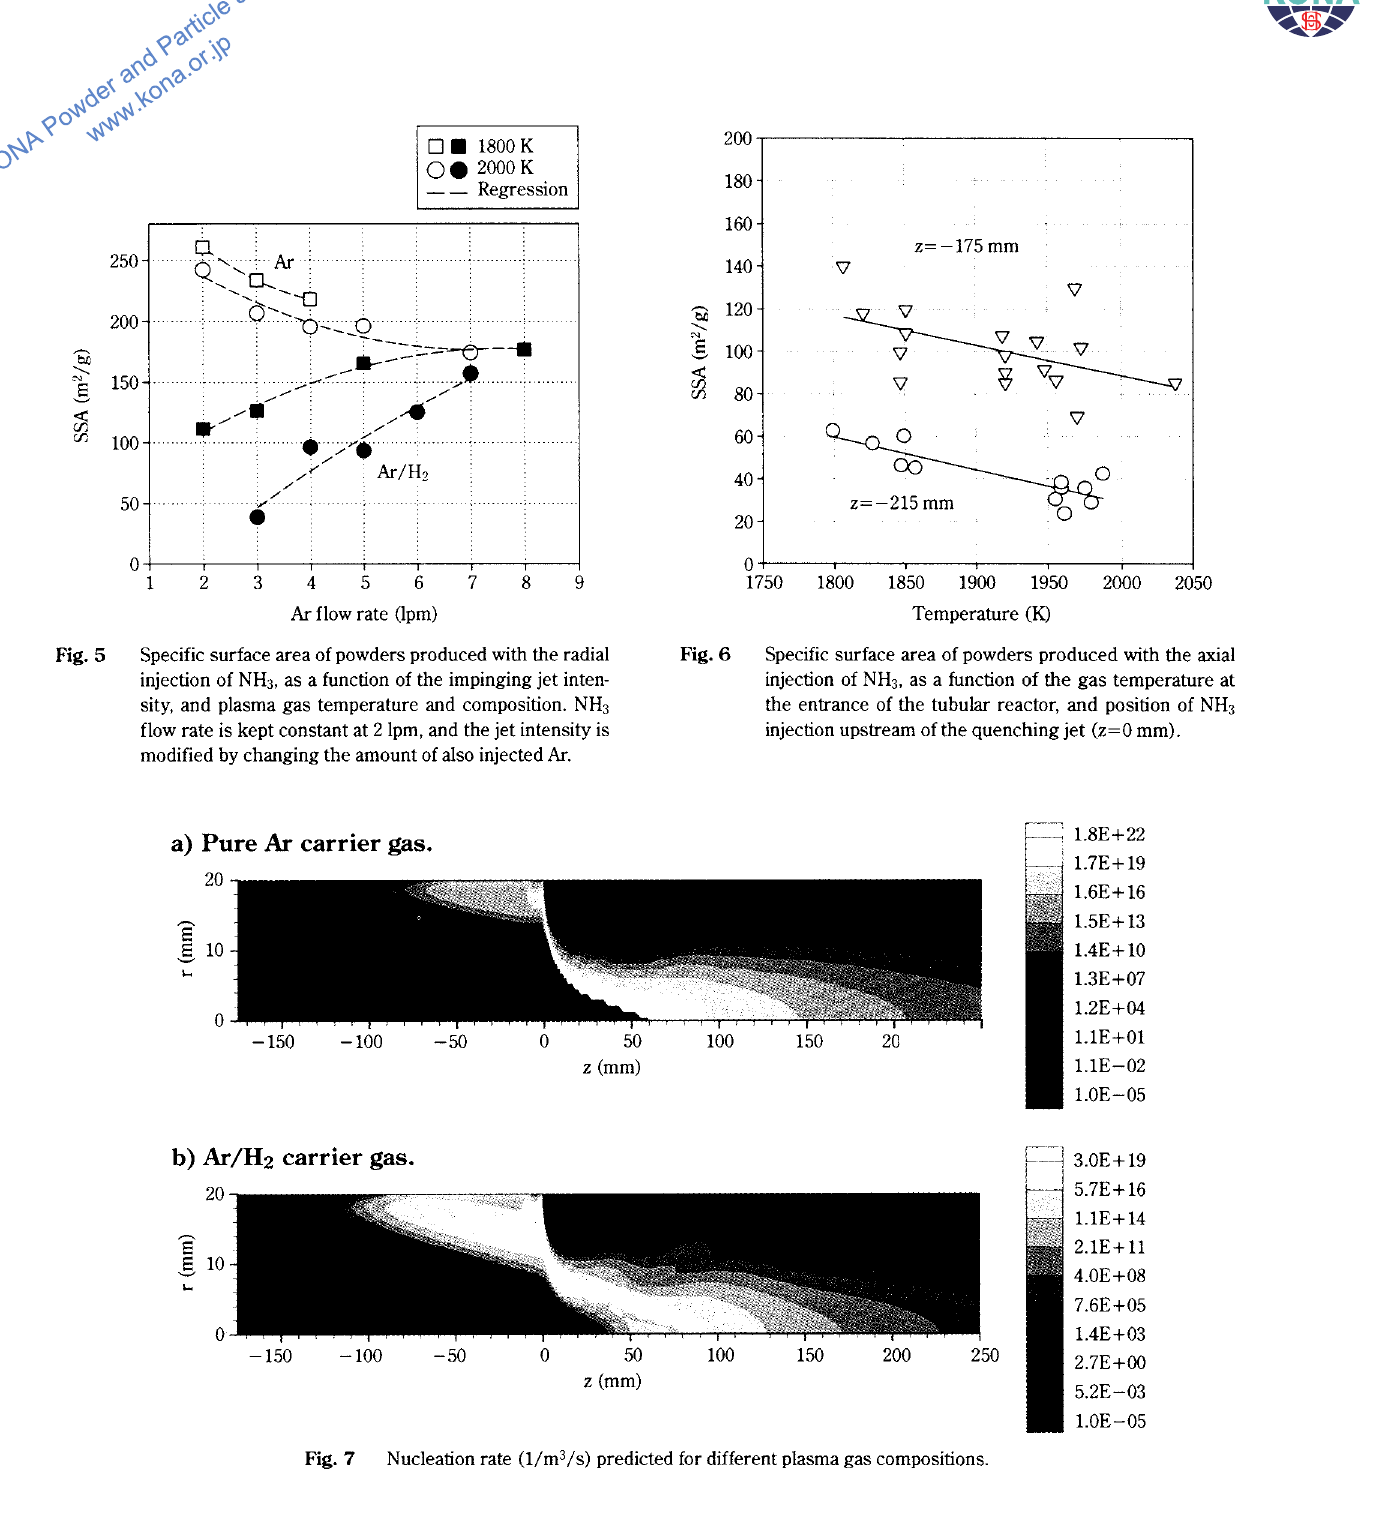
Fig. 7 Nucleation rate (1/m 3 /s) predicted for different plasma gas compositions.